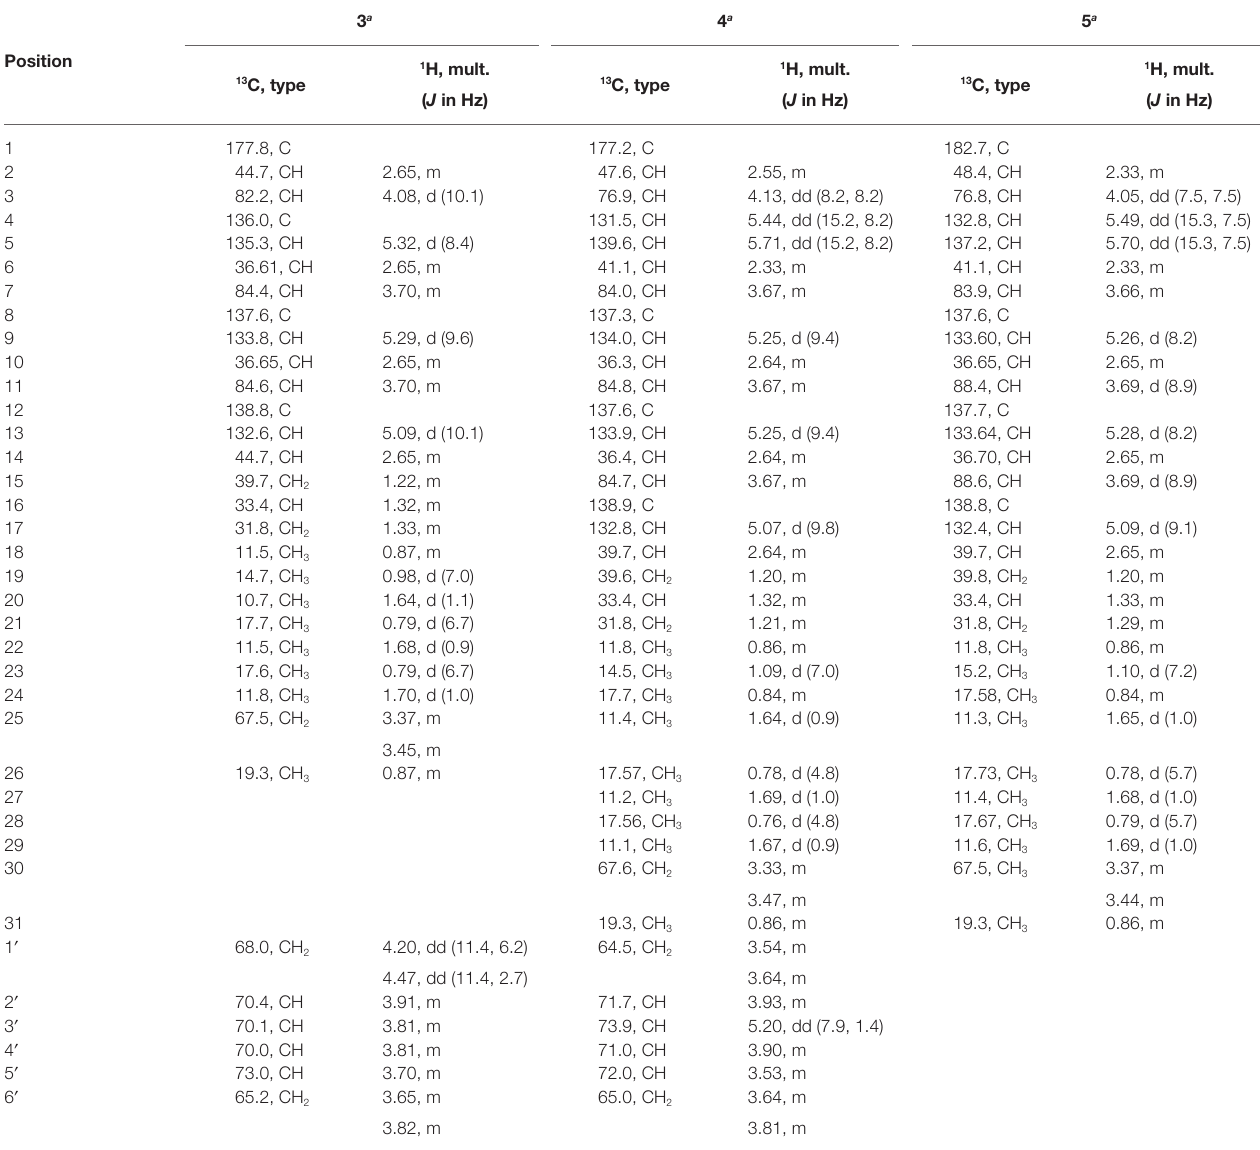
TABLE 3 | NMR spectral data of muyocopronols A ( 3 ), B ( 4 ), and C ( 5 ).